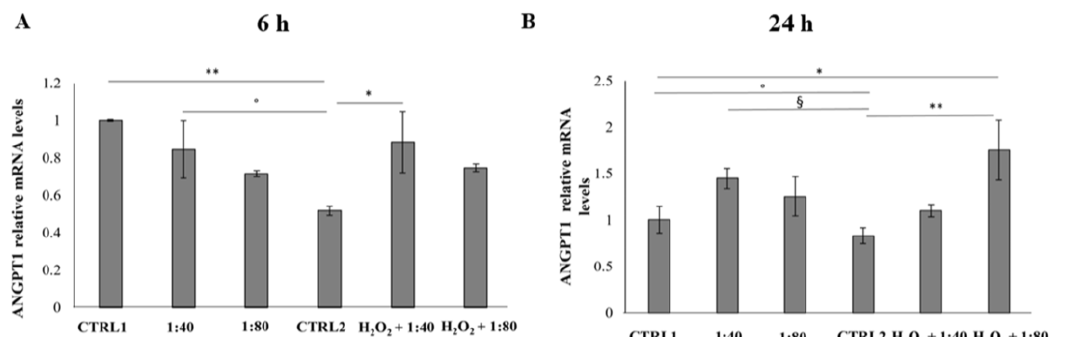
Figure 8. Relative gene expression of Angiopoietin 1 (ANGPT1) in HGFs exposed to DMEM culture medium (CTRL1), SS diluted 1:40 and 1:80, HGFs pre-treated with H 2 O 2 100 µ M then exposed to DMEM culture medium (CTRL2) and to SS diluted 1:40 and 1:80 for 6 h ( A ) and 24 h ( B ). Data are expressed as relative to CTRL1 (calibrator sample defined as 1). The most representative of three separate experiments is shown. The bar graph displays densitometric values expressed as mean ± standard deviation, Y-axis, fold change. 6 h: ** CTRL1 vs. CTRL2 p = 0.0073; * CTRL2 vs. H 2 O 2 + 1:40 p = 0.0257; ◦ CTRL2 vs. 1:40 p = 0.0427 24 h: ** CTRL2 vs. H 2 O 2 + 1:80; * CTRL1 vs. H 2 O 2 + 1:80 p = 0.0207; ◦ CTRL1 vs. CTRL2 p = 0.0635; § CTRL2 vs. 1:40 p =